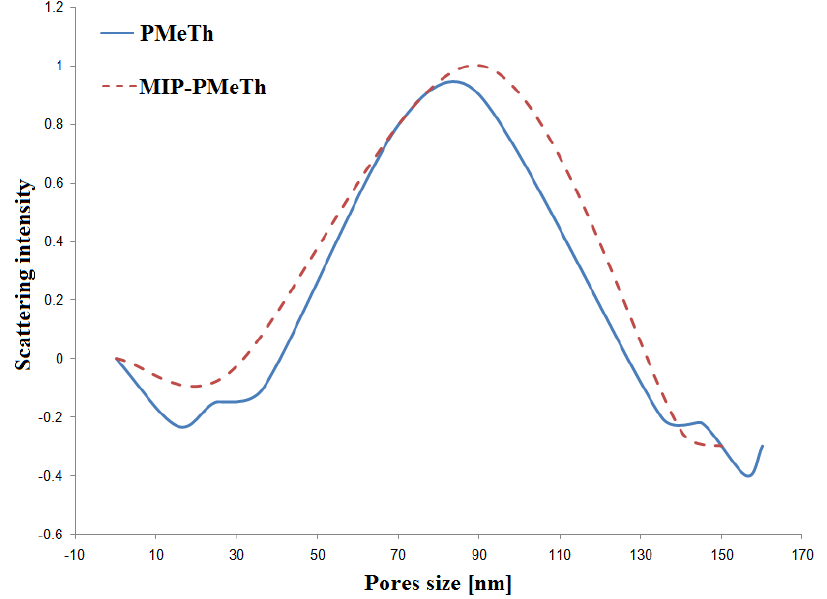
Figure 7. SPME-PMeTh fiber porosity measurement with SAXS (for AMOX).